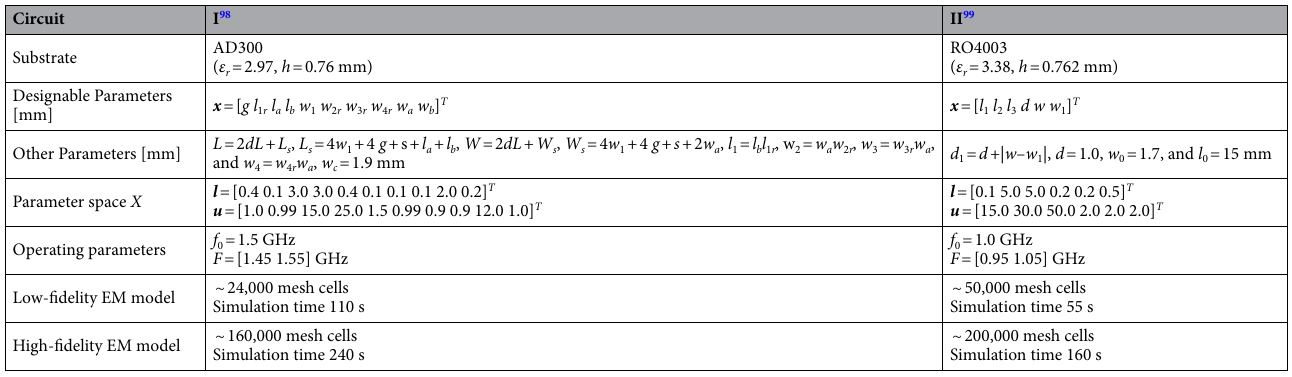
Table 4. Essential parameters of Circuits I and II of Fig. 9.